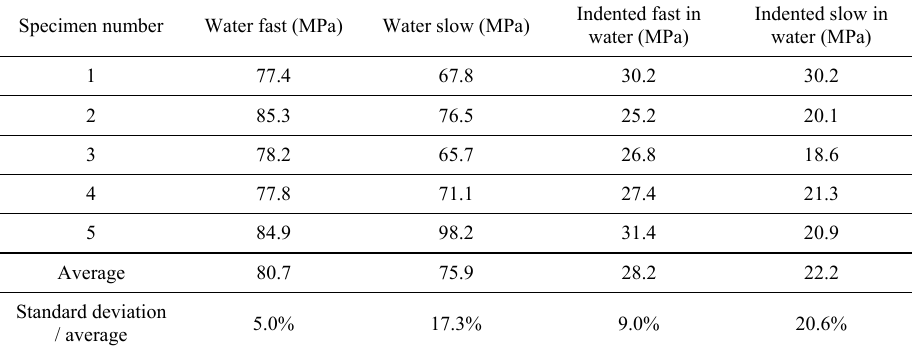
Table 4: Comparison of undamaged and indented bars in water at 20°C